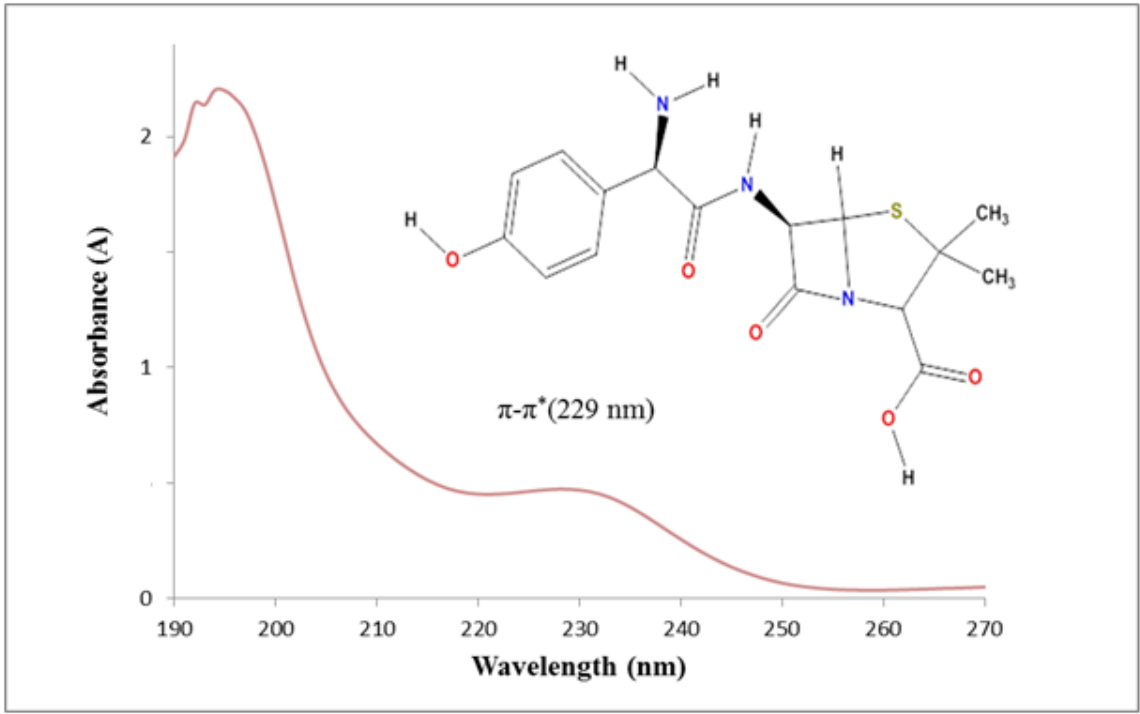
Figure 2. UV spectrum and molecular structure of 20 mg/L AMX.